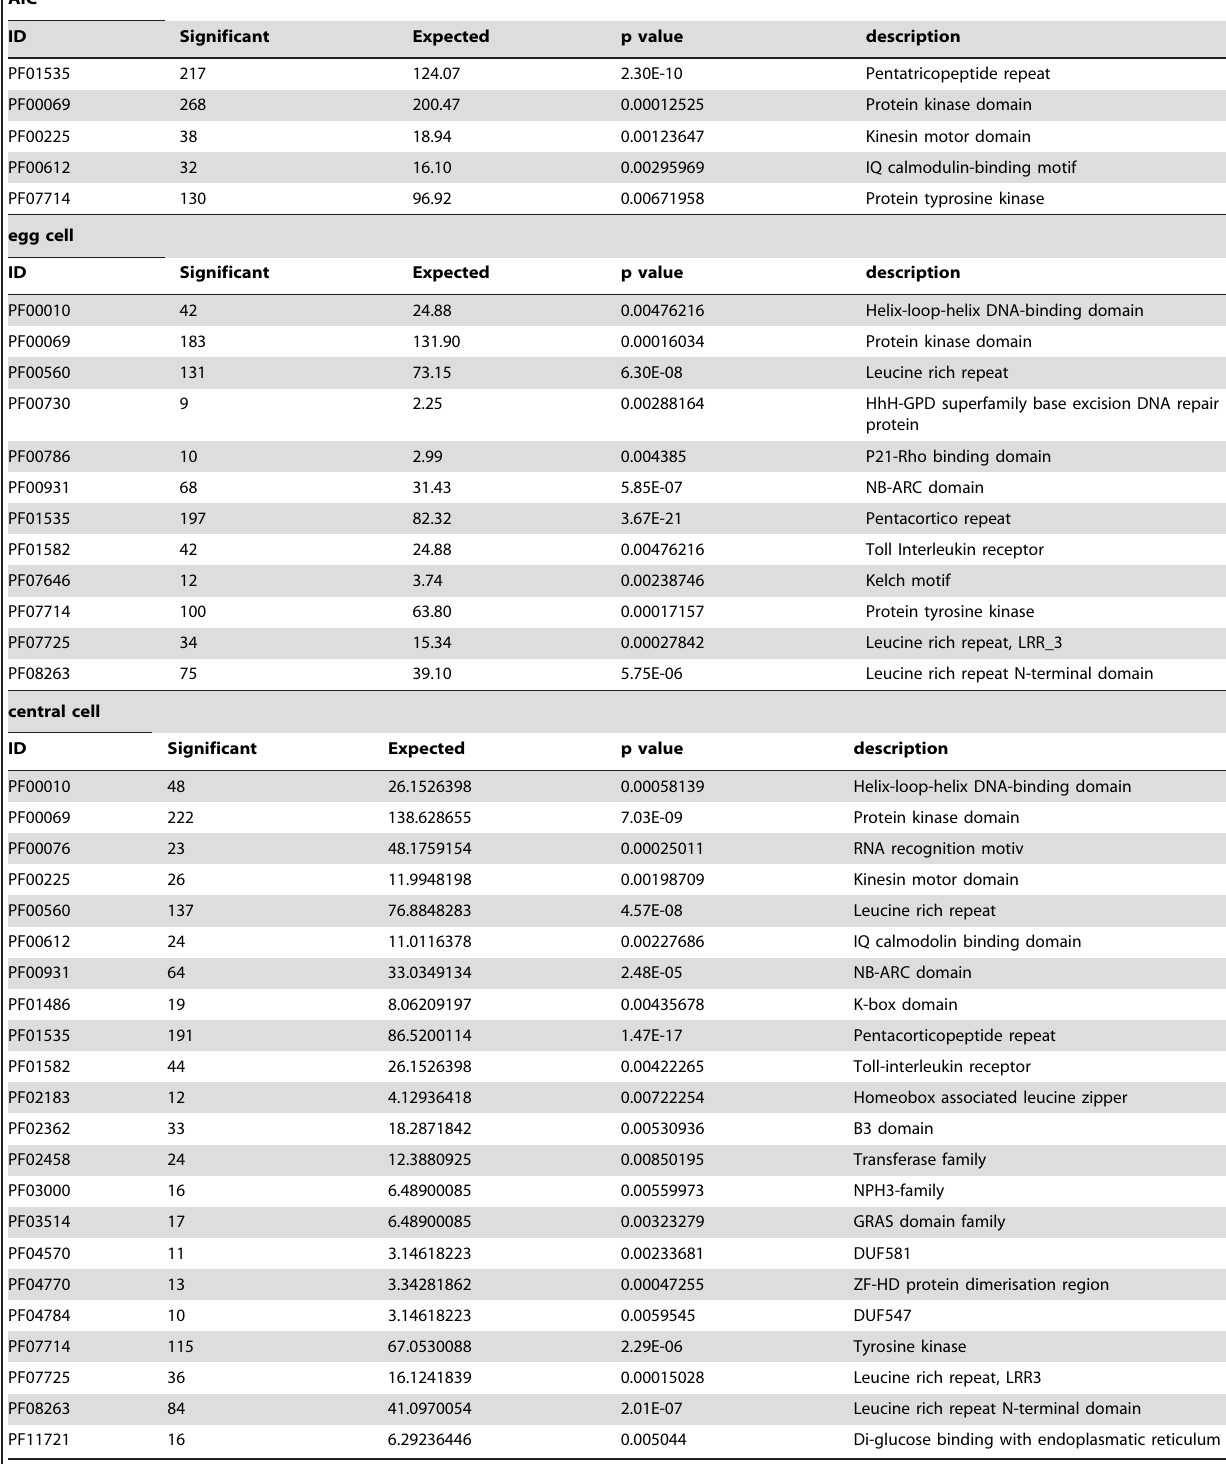
Table 5. Analysis of PFAM domains significantly enriched in the Boechera